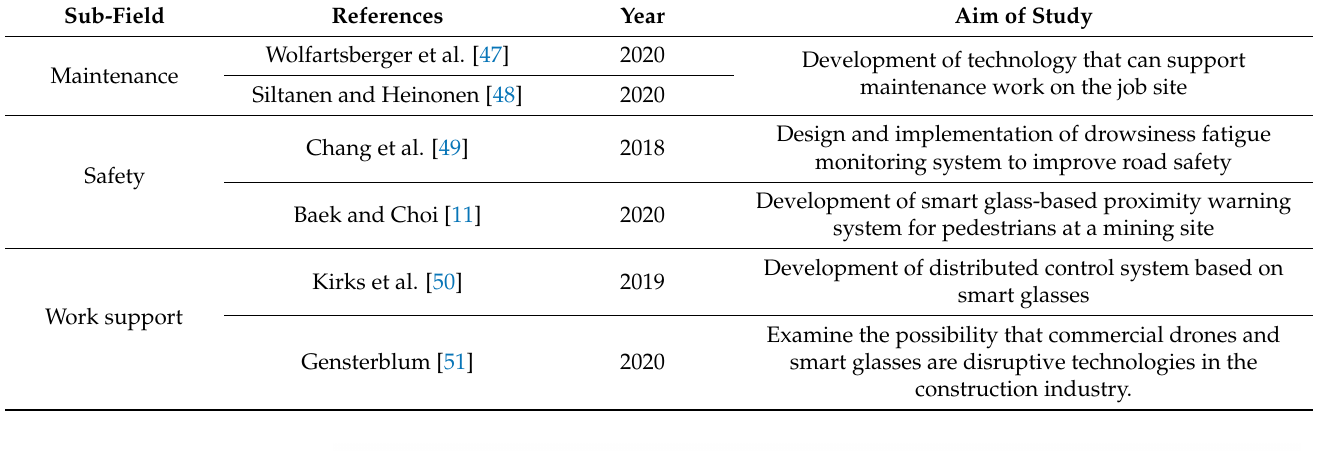
Table 3. Summary of smart glass applications in the industry field.